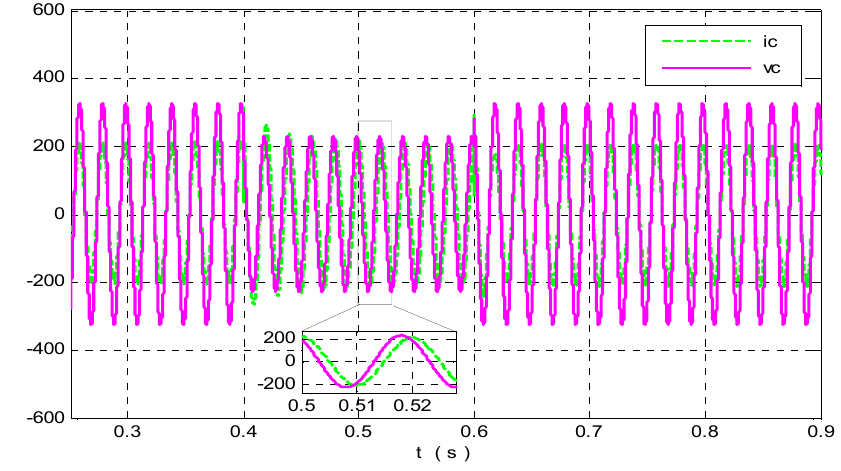
Electronics 2018 , 7 , x FOR PEER REVIEW